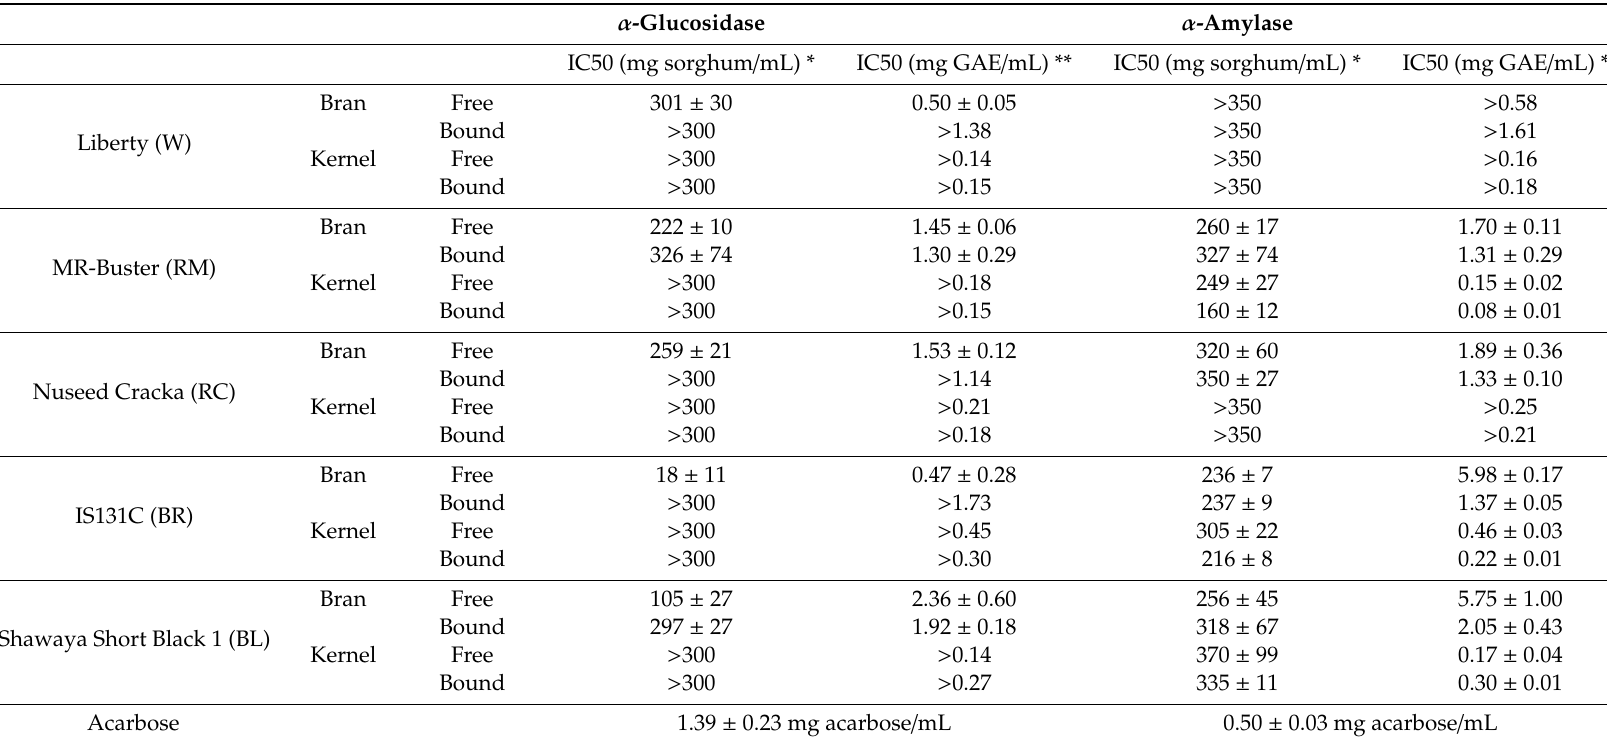
Table 1. Half-maximal inhibitory concentration (IC50) values of sorghum phenolic extracts and acarbose against α -glucosidase and α -amylase. α -Glucosidase α